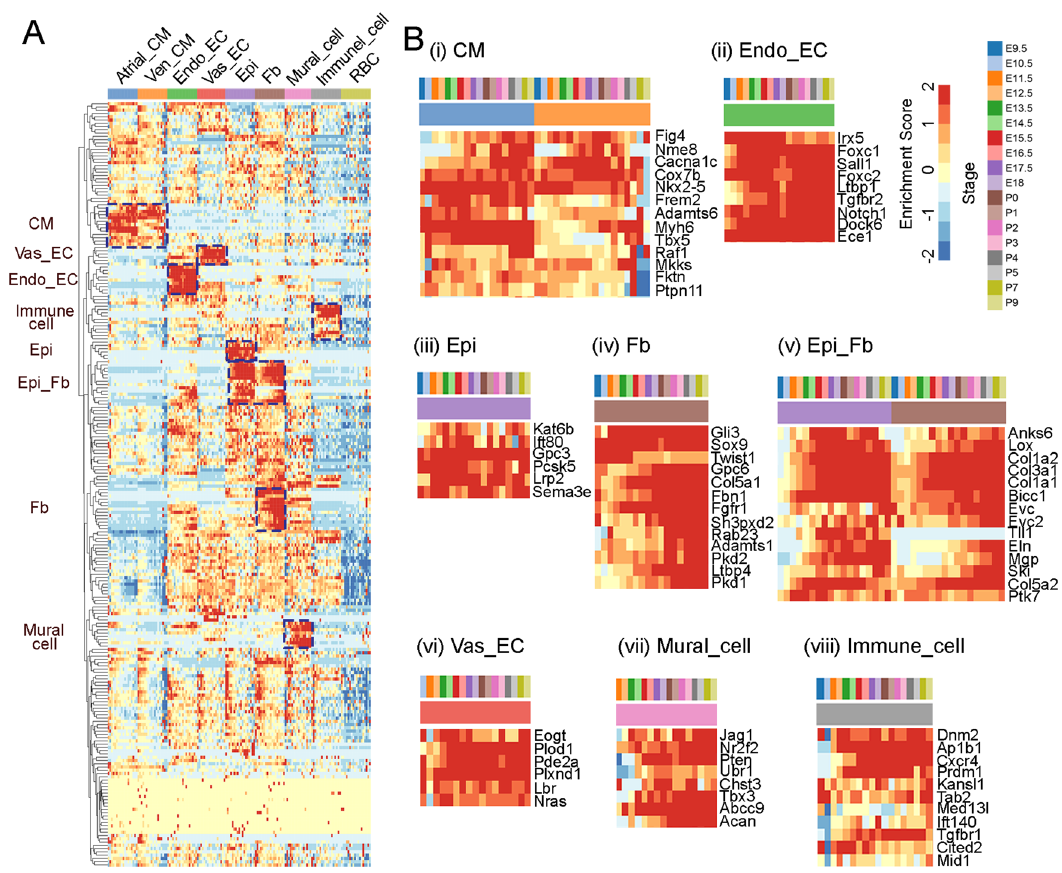
Fig. 6 | Expression pattern analysis of CHD genes using scRNA-seq data. A Unsupervised clustering analysis of CHD genes revealed stage and cell type- speci fi cexpressionpatterns. B (i – viii)theenlargedexpressionheatmapofcelltype-